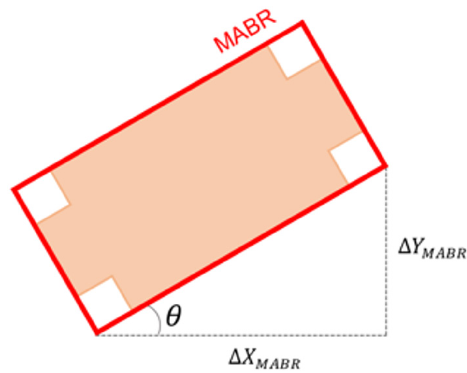
Fig. 2. MABR and orientation angle of a polygon